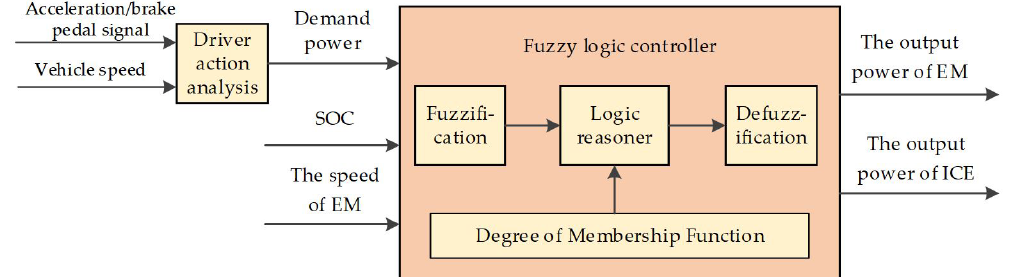
Figure 3. The basic principles of a fuzzy logic rule-based